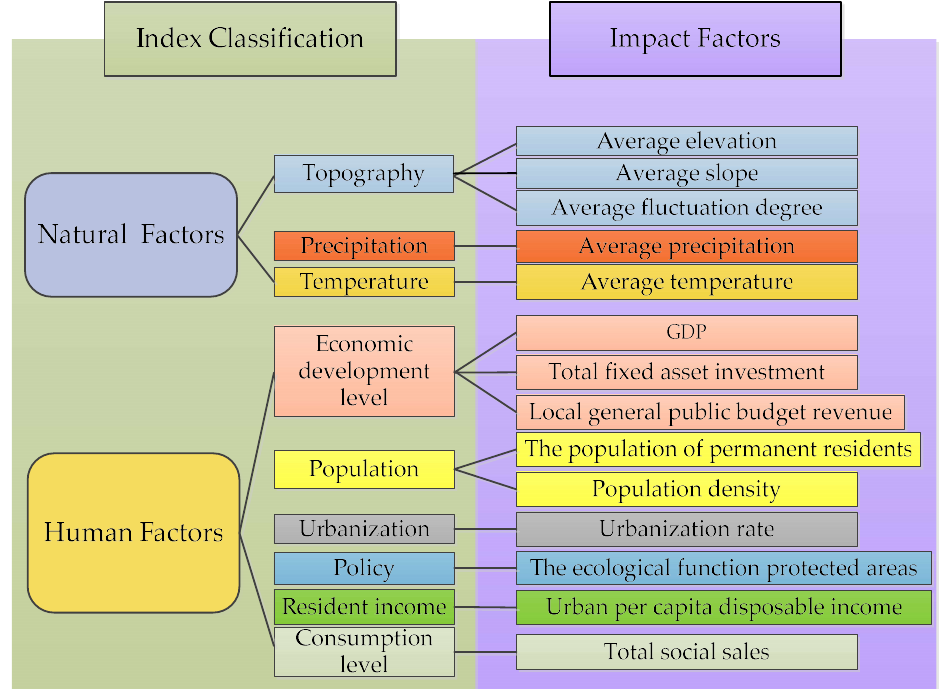
Figure 2. Influencing factors of territorial space evolution in the Yangtze River Economic